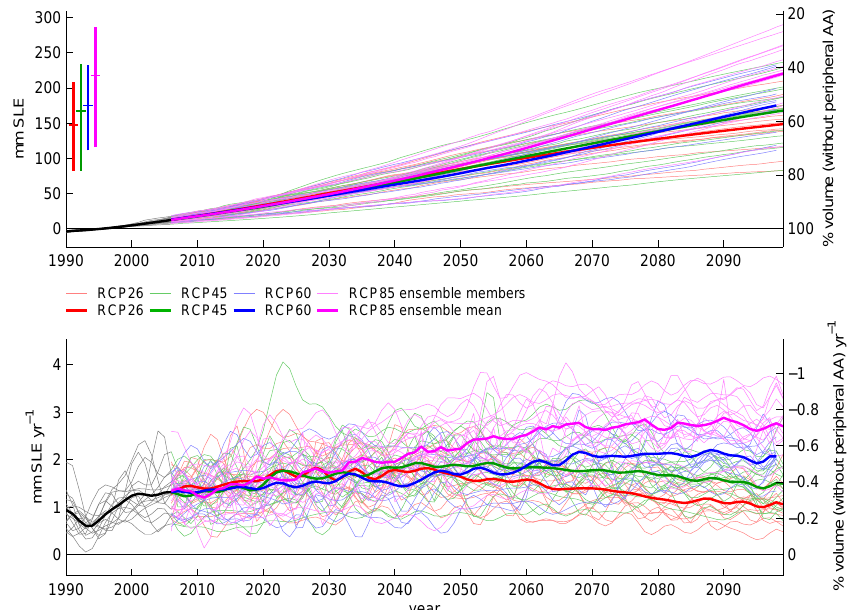
Fig. 22. Cumulative global surface mass balances relative to the 1986–2005 mean (upper panel), and rates (lower panel) from the model forced with CMIP5 projections, up to the year 2100. Light colored lines: model forced by individual CMIP5 ensemble members, solid lines: means of light colored lines. Crosses on the left (upper panel) indicate mean and range of ensemble for each RCP scenario in the year 2100. Rates have been filtered with a 5yr low pass filter for